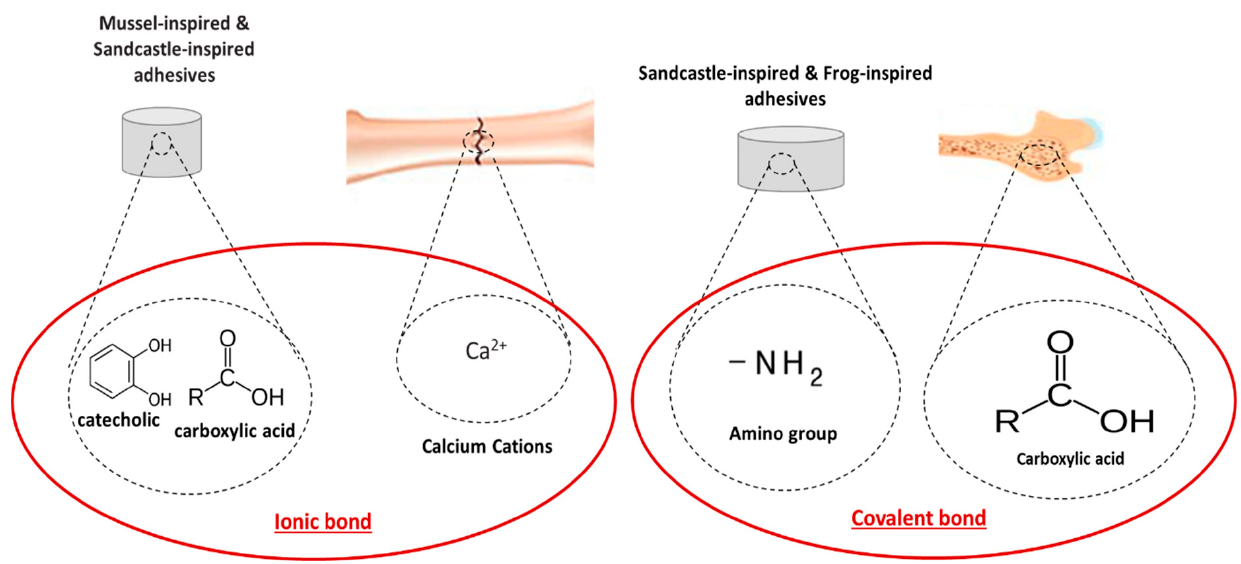
Figure 10. Ionic bond between catecholic hydroxyl and carboxylic acid groups of adhesive systems with Ca2+ present on the surface of bone as a mechanism of adhesion of mussel − and sandcastle − in- spired adhesives, and covalent bond between carboxylic acid of adhesive system with amines pre- sent in bone collagen matrix for frog − and sandcastle − inspired adhesives.